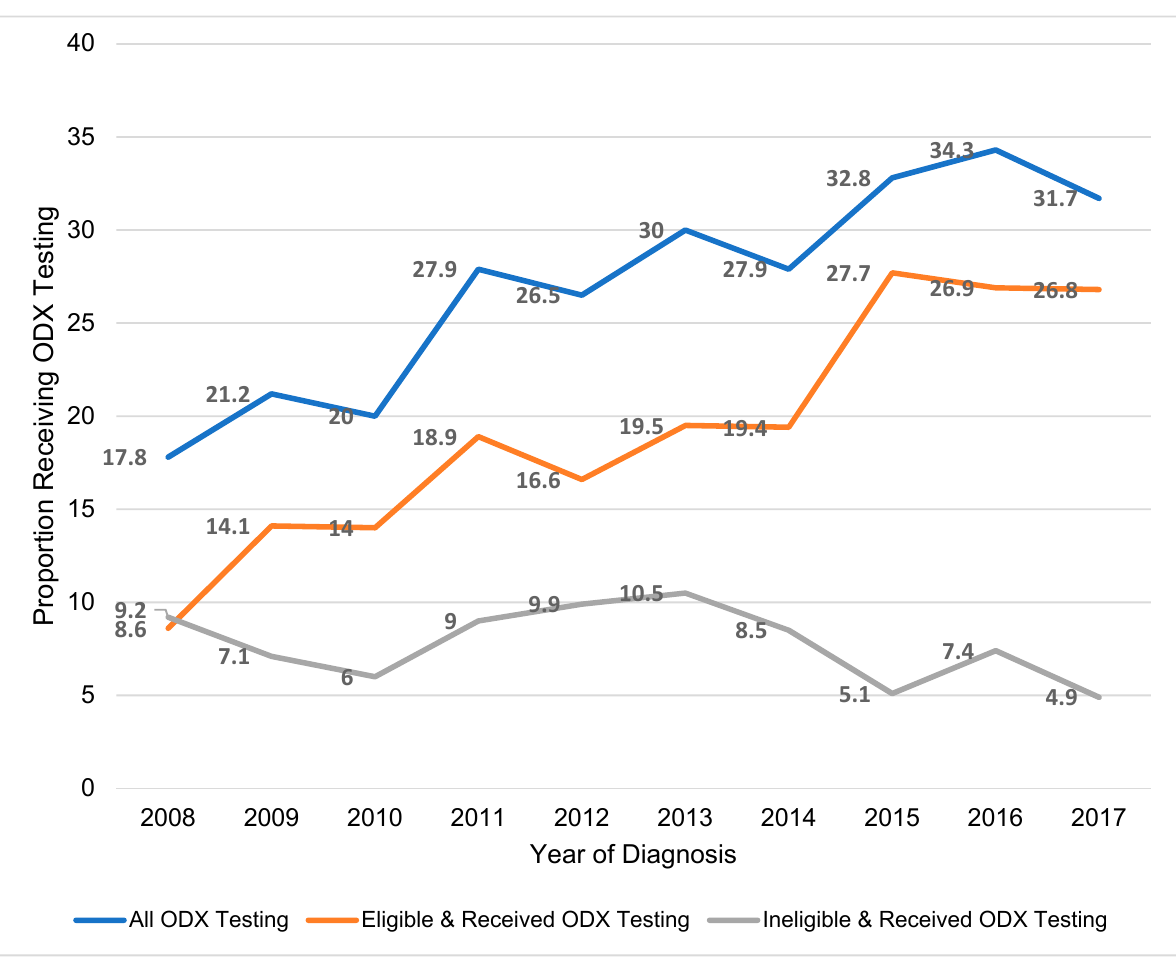
Figure 2. Proportion of all Latina/Hispanic women in New Jersey diagnosed with early invasive BC who received ODX testing.